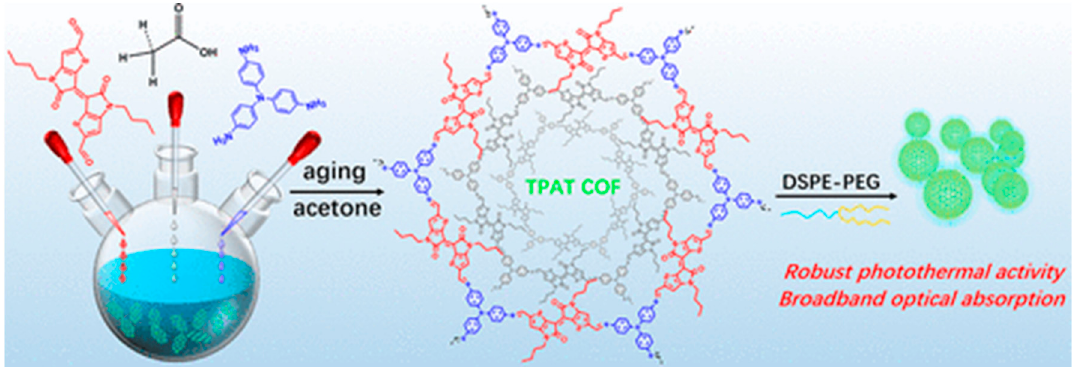
Figure 7. Schematic diagram of the synthesis of TPAT COF and its photothermal application to tumors. Reprinted with permission from ref [77] . Copyright 2022 American Chemical Society.